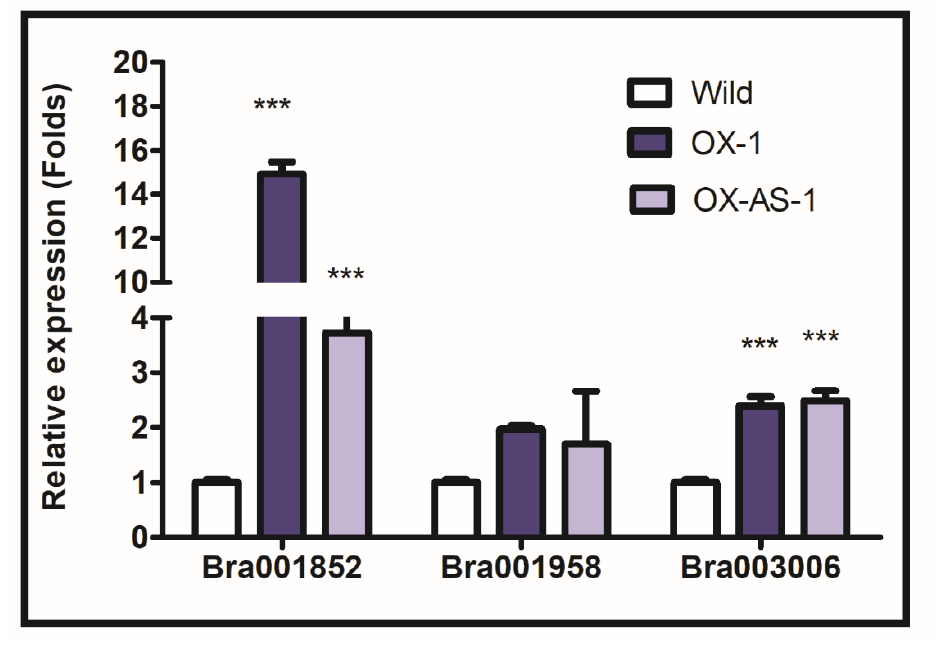
Figure 6. Expression changes of the BrEXLB1 interacting genes in OX-1 and OX-AS-1 transgenic and wild type B. rapa plants. *** represents the statistical significance.